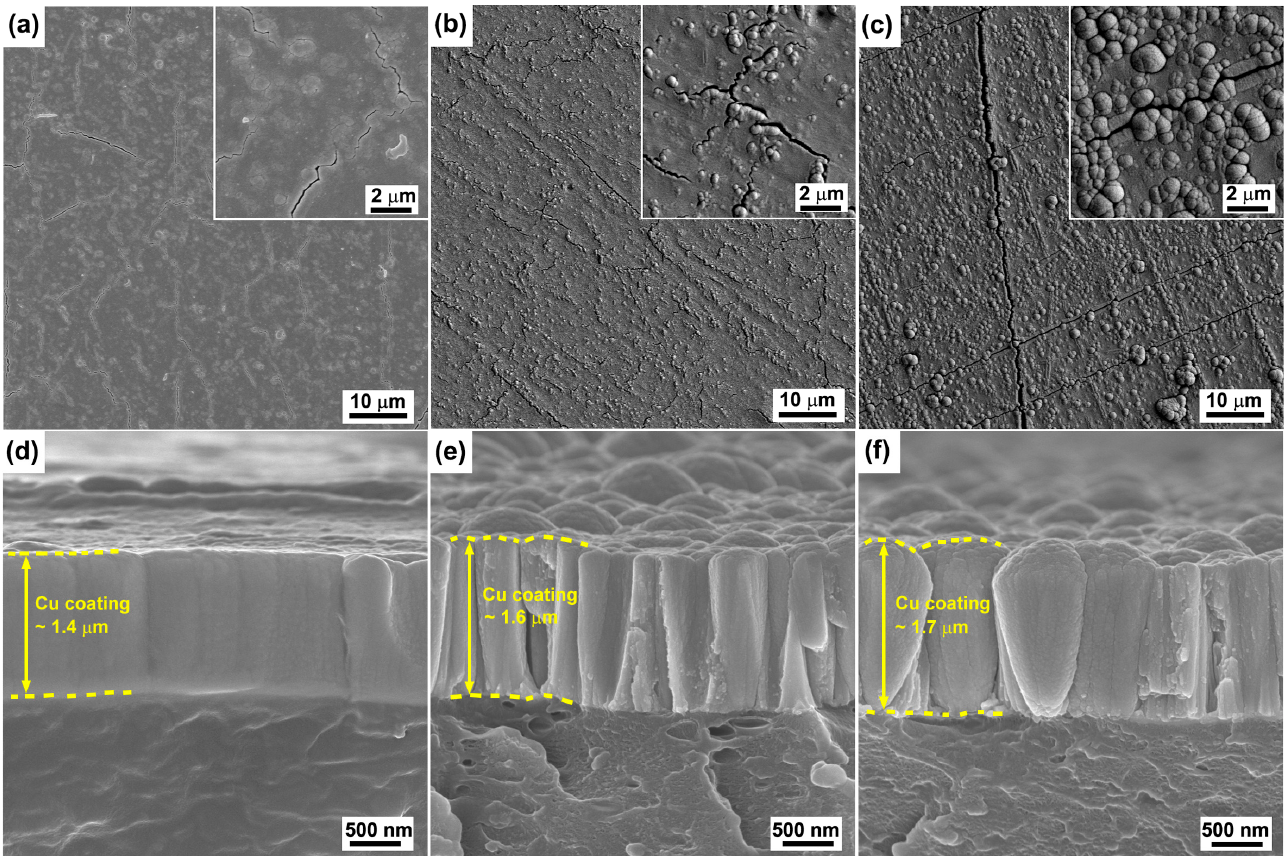
Figure 5. Typical surface topographies of the Cu coatings deposited on the raw ABS ( a ) and the ABS treated by Cr ions for 30 s ( b ) and 3 min ( c ) with bias voltage of − 400 V. ( d ), ( e ), and ( f ) are corresponding cross-sectional SEM images of ( a ), ( b ), and ( c ), respectively.